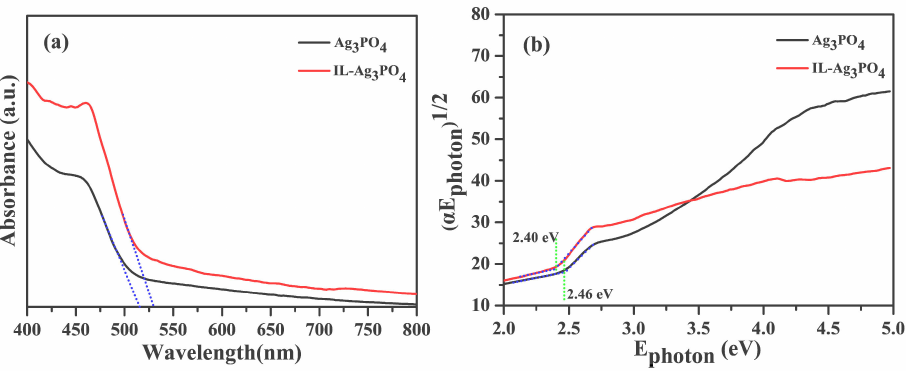
Figure 3. ( a ) UV-visible diffuse reflectance spectra (UV-vis DRS), and ( b ) the corresponding (ahv) 1/2 vs. hv plots of Ag 3 PO 4 and IL-Ag 3 PO 4